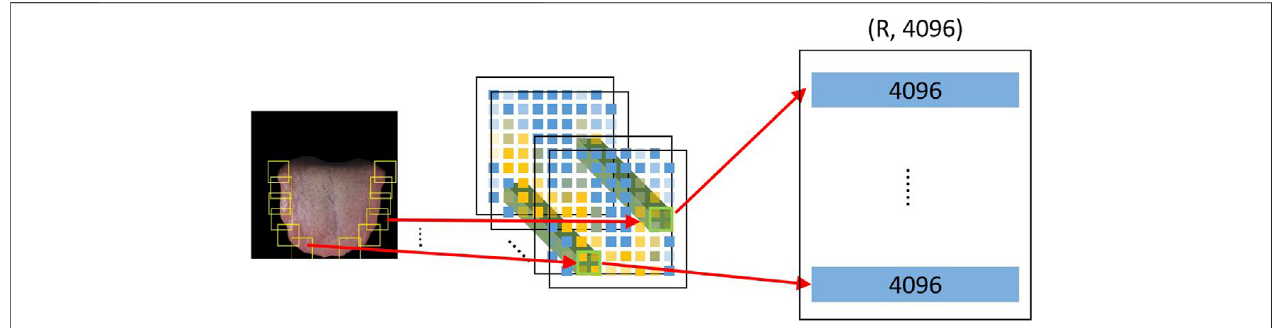
FIGURE 4 | SPP layer. The green cuboid represents the deep feature of the tooth mark candidate area, and R represents the number of tooth mark candidate areas. It transforms the (h, w, 512) features of the R tooth mark candidate regions into a uni fi ed (R, 4096) size, h and w separately represent the height and width of the tooth mark candidate